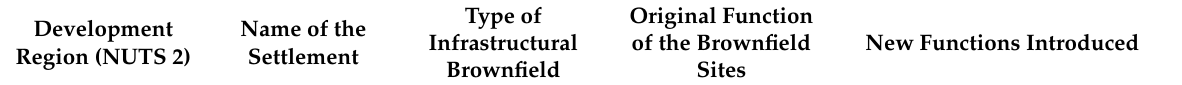
Table 6. Redevelopment projects for infrastructural